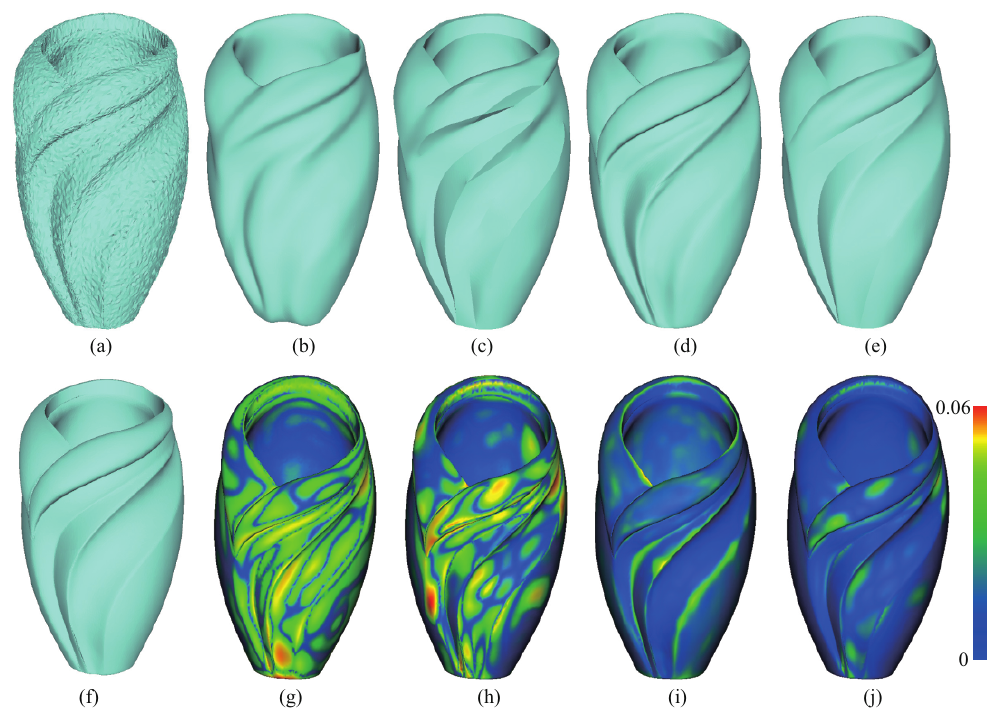
Fig. 8 Vase. (a) Input noisy model corrupted by Gaussian noise ( σ = 0 . 1¯ l e ) and 10% impulsive noise with scale 0 . 5¯ l e , (b–e) subdivision surfaces reconstructed using Loop subdivision, the rules in Ref. [2], the method of Ref. [25], and our method, (f) ground truth model, and (g–j) error distributions for (b–e) respectively.